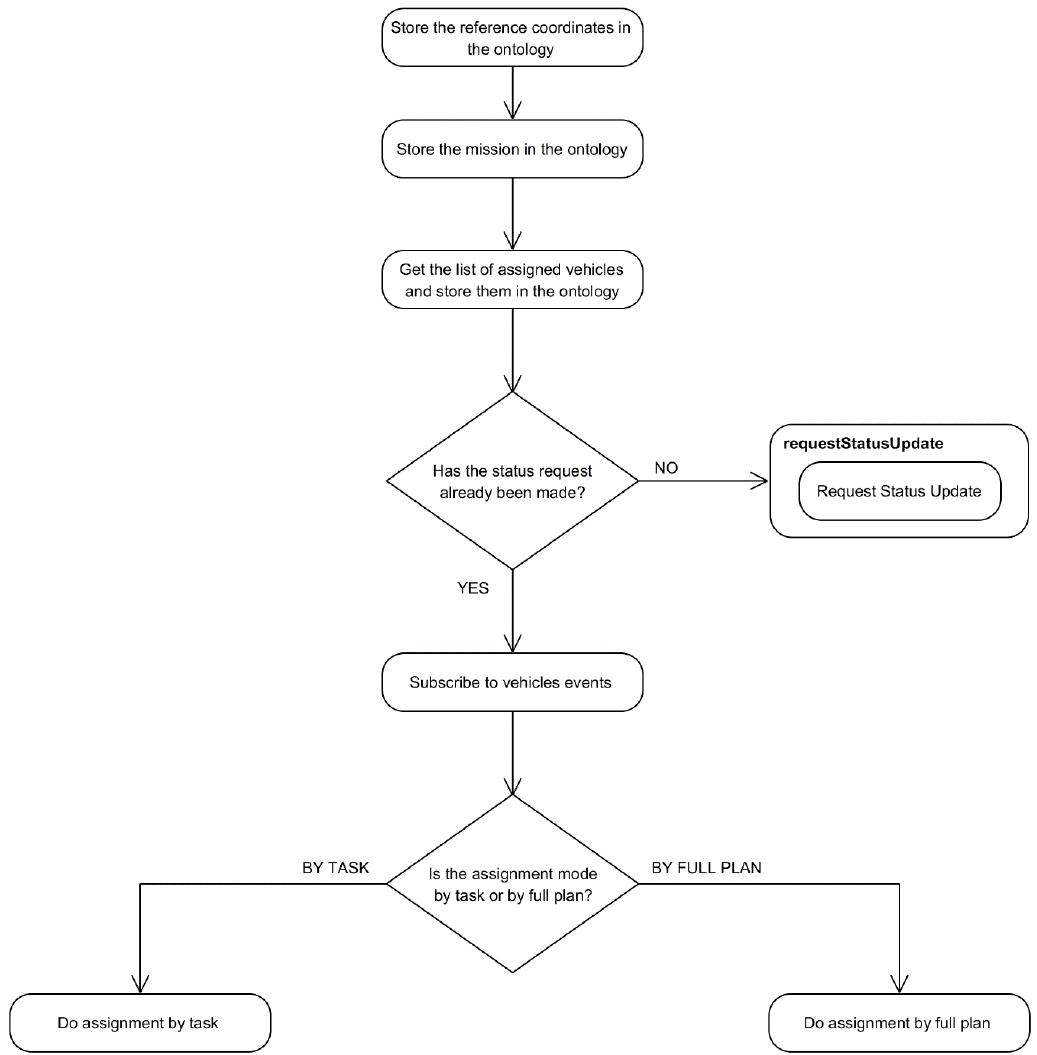
Figure 11. Flow diagram for mission data extraction and storage done at the MTRR.